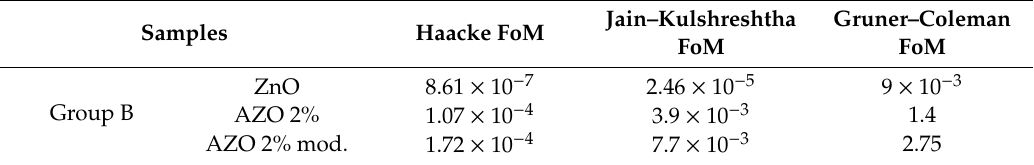
Table 6. Calculated figure-of-merit (FoM) values for Group B samples after the additional heat treatment through three di ff erent